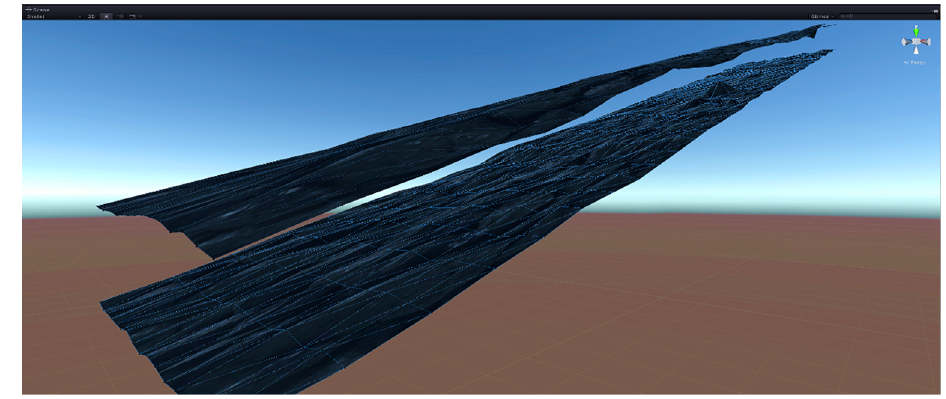
Figure 7. Mesh of virtual coal seam roof and floor.